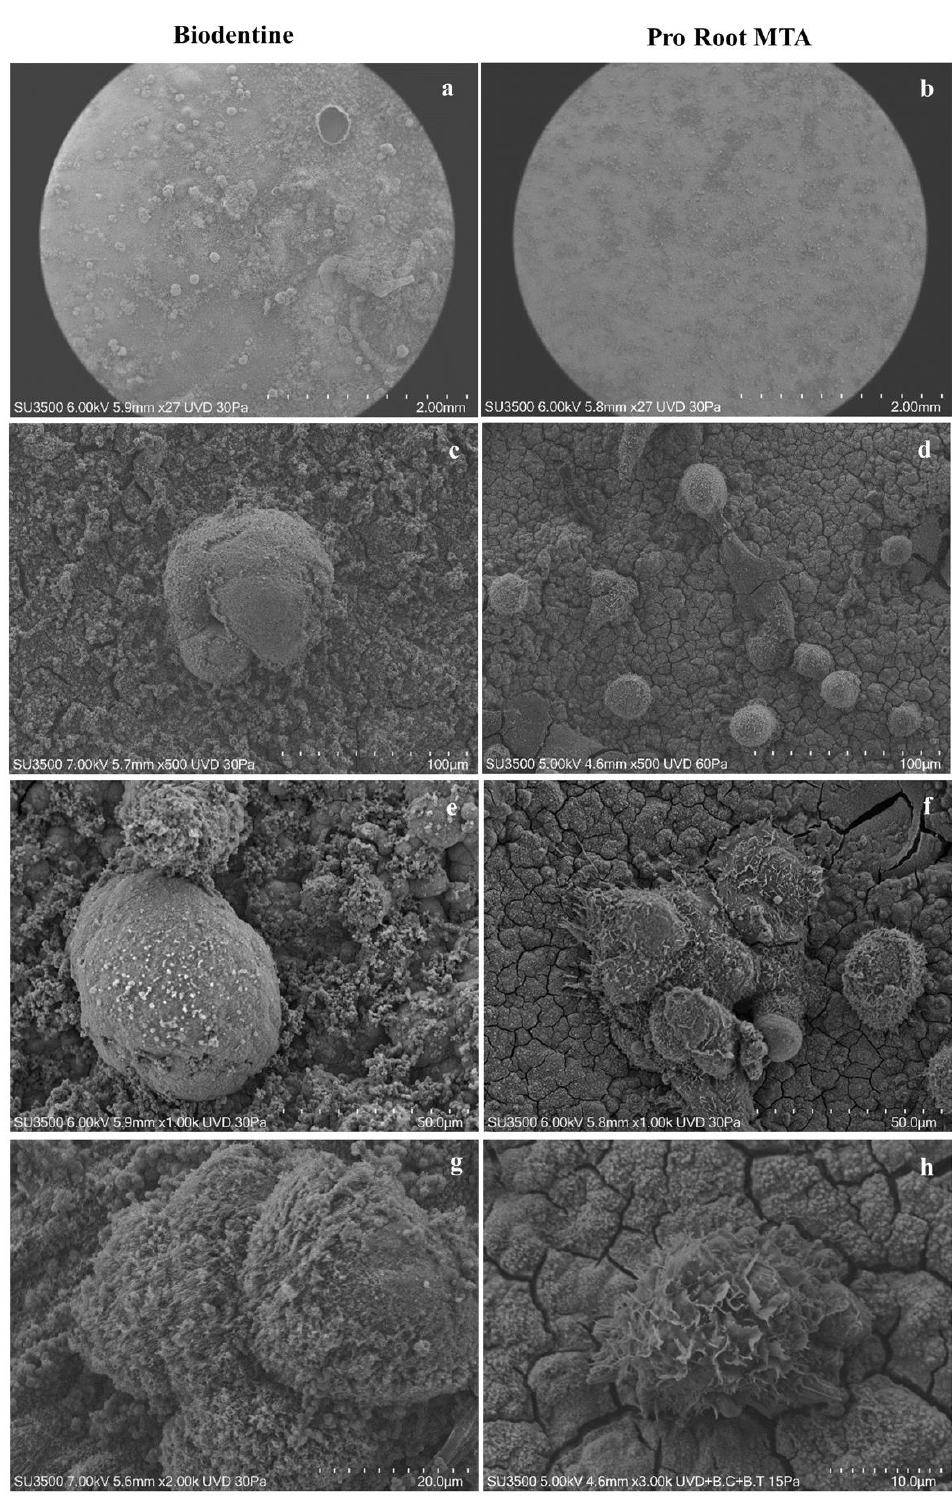
Figure 7. Biodentine and ProRoot and disks seeded with Saos-2 cells. ( a ) Biodentine disk, panoramic view at very low magnification. Disk surface was extremely rough and covered with spheroidal aggregates of varying sizes and uneven distribution. Magnification 27 × . ( b ) ProRoot MTA disk, panoramic view at very low magnification. Disc surface appears to be dotted with a large number of evenly distributed cells. Magnification 27 × . ( c ) Biodentine disk, a cluster of 4 or 5 overlapping cellular elements was visible. Cells appeared to be deformed, free of cytoplasmic projections, and partially covered with a granular coating. Magnification 500 × . ( d ) ProRoot MTA disk, the individual cellular elements were visible. A round or flattened shape could be observed, with cytoplasmic projections. Magnification 500 × . ( e ) Biodentine disk, an aggregate of cells with a smooth surface and remnants of microvilli could be observed. Magnification 1000 × . ( f )